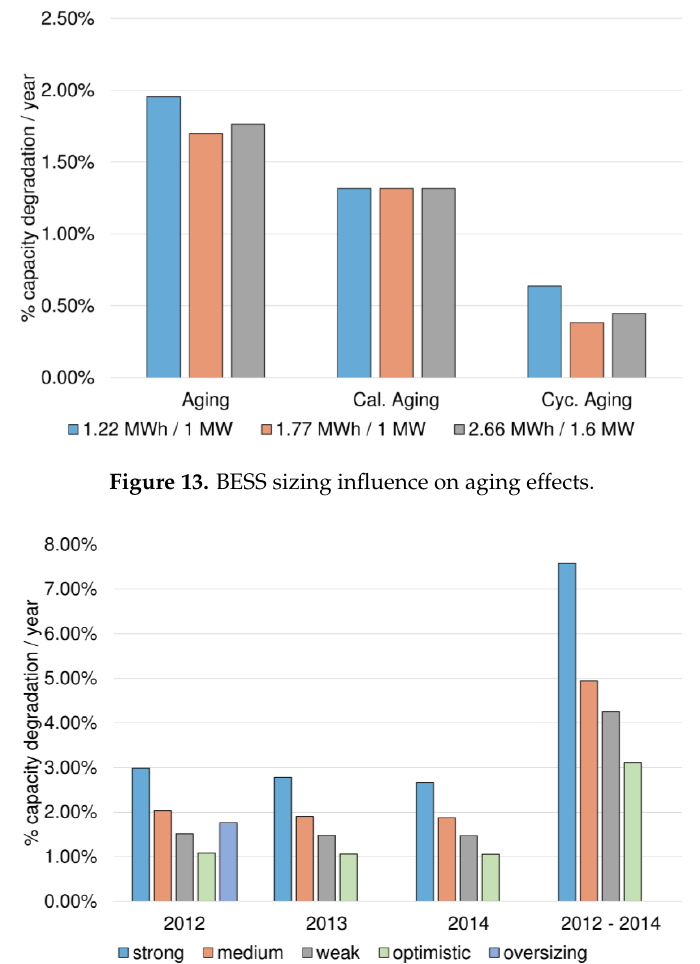
Figure 14. Aging influence of predefined scenarios on overall BESS performance (mean values of BESS power and sizes were taken into account for better results).